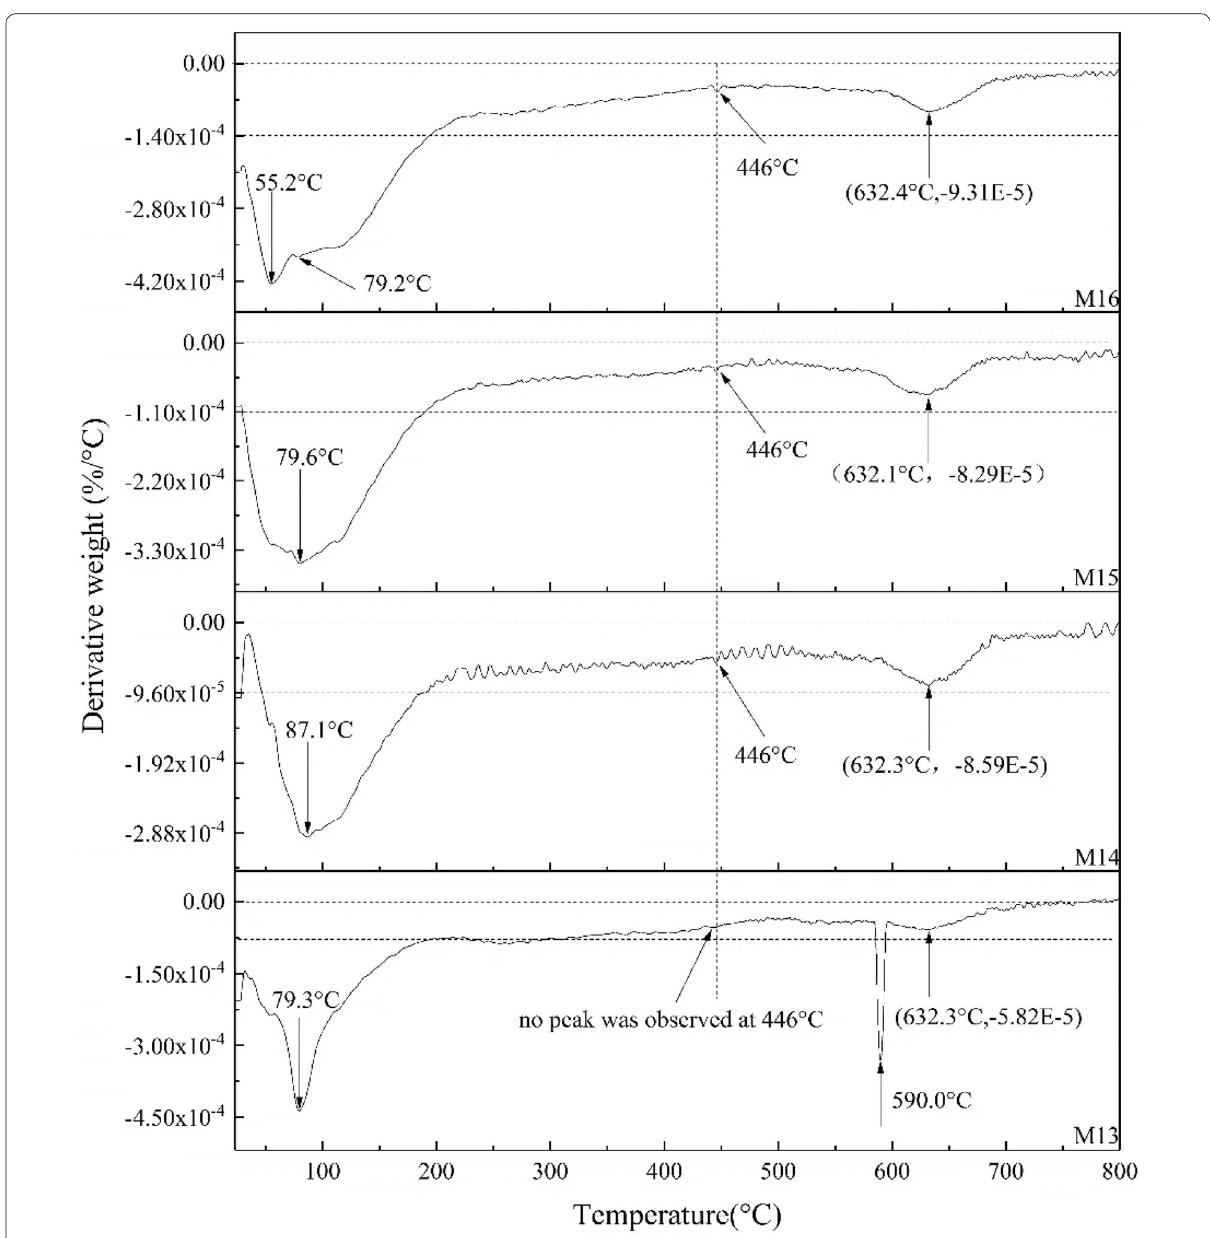
Fig. 11 DTG curves of M13 to M16 FAGC